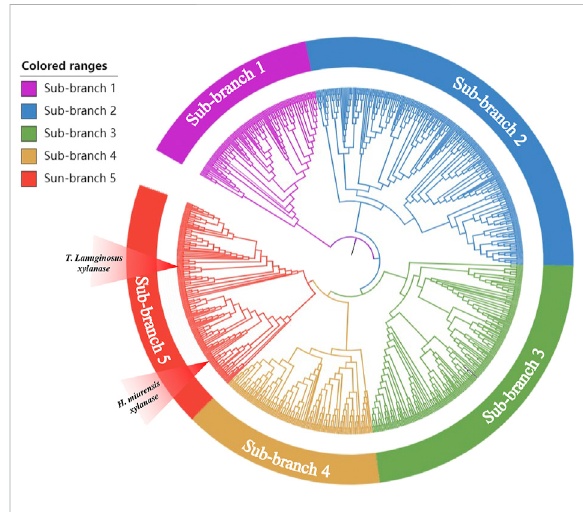
FIGURE 1 Phylogenetic analysis of xylanases with Thermomyces lanuginosus xylanase as the reference. Thermomyces lanuginosus xylanase located in the red